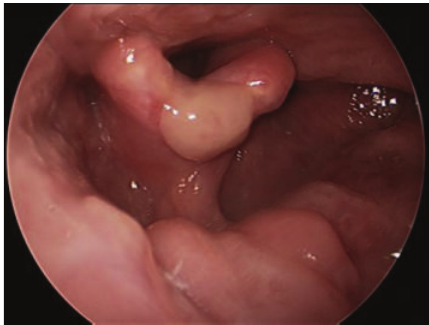
Figure 3: Post-op follow-up picture after 1 year shows no signs of